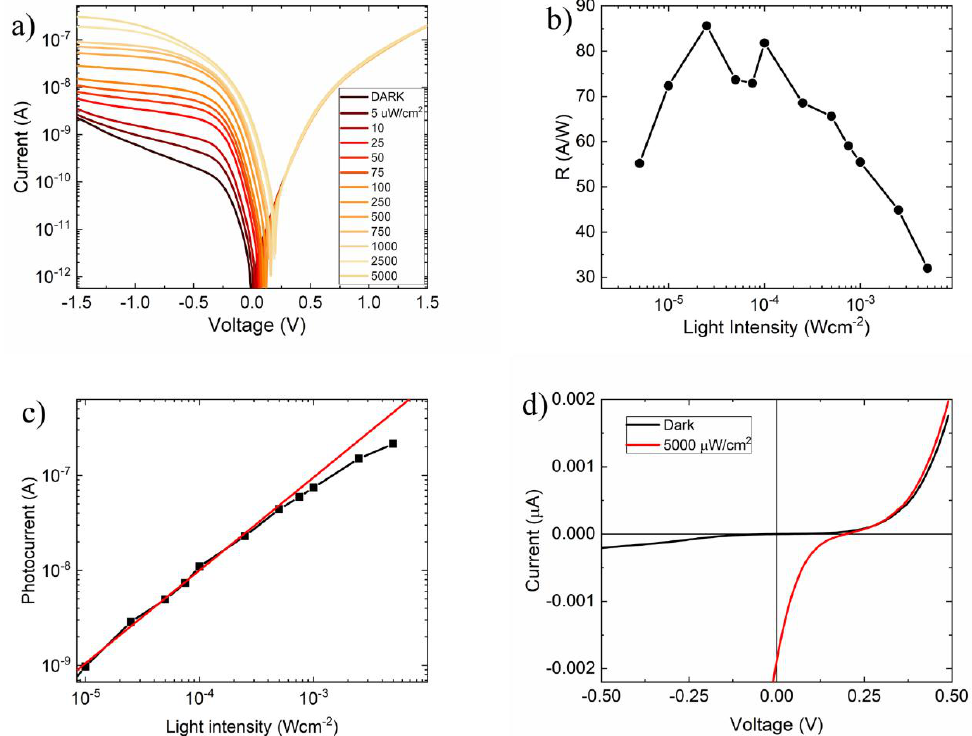
Figure 5. ( a ) I-V characteristic in semilogarithmic scale of the gr/Si pillar device measured at different intensity illumination level. ( b ) Responsivity of the gr/Si pillar device as function of the light intensity. ( c ) Photocurrent measured at − 1 V and at di ff erent light intensities in logarithmic scale. ( d ) I-V characteristic measured in dark (black line) and at 5 mWcm −2 (red line).